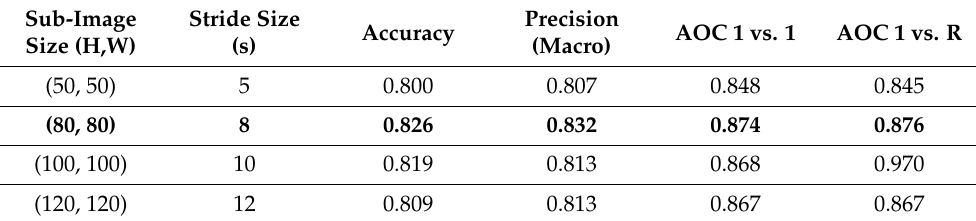
Table 3. Classification metrics for the complete grove validation set.